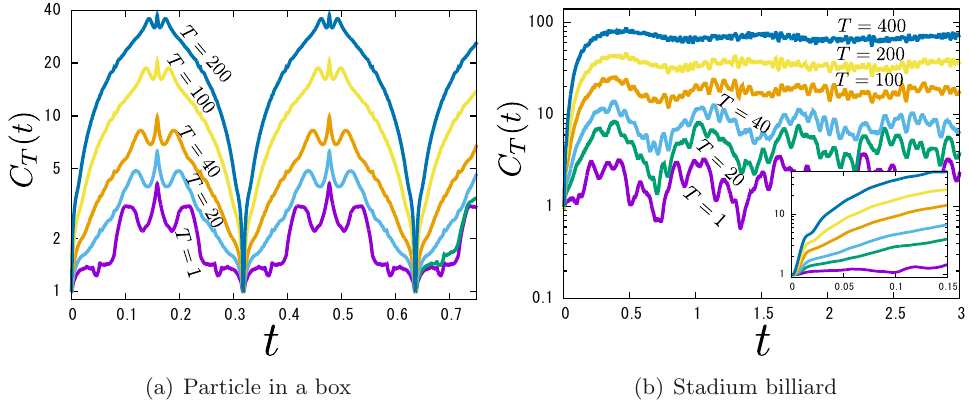
Figure 1 . The OTOC C T ( t ) = [ x ( t ) , p (0)] 2 of a particle in a 1D box (a) and that of a billiard −h i (b). T represents the temperature of the systems. We find a clear distinction between the two: the OTOC for the particle in a box periodically comes back to its initial value (= 1), while that for stadium billiard saturates to a constant value. The asymptotic value grows with the temperature. In the inset of the right panel, we show the early time evolution of the OTOC. We find no clear exponential growth of the